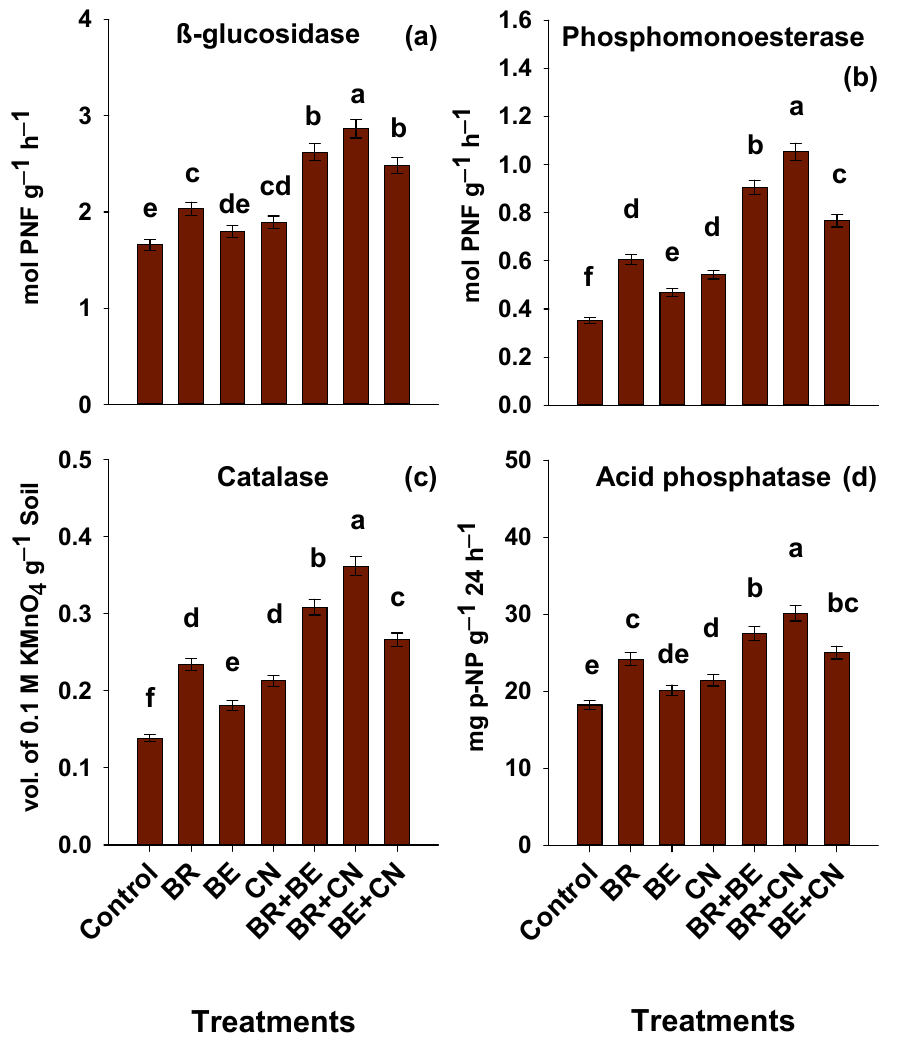
Figure 3. β -glucosidase ( a ), phosphomonoesterase ( b ), catalase ( c ), acid phosphatase ( d ) activities in the soil after harvest of lentil plants as influenced by adding BR, BE, and CN in a Ni-affected soil. Values characterized by the same letter are not significantly different at the α = 0.05 level. These values are the mean of three replicates ±